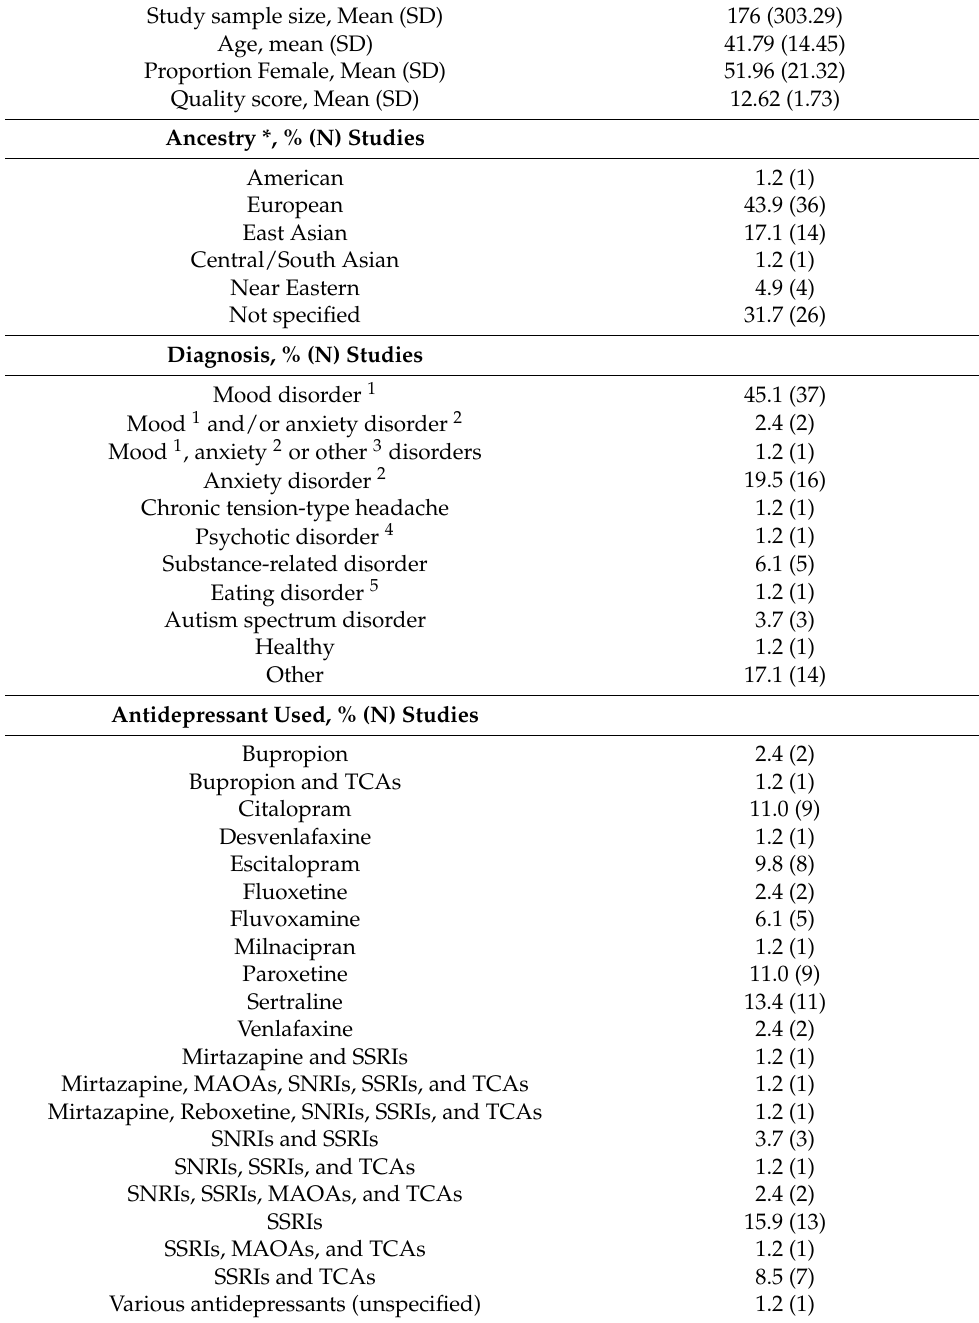
Table 1. Summary characteristics of the included studies in the systematic review (N = 82